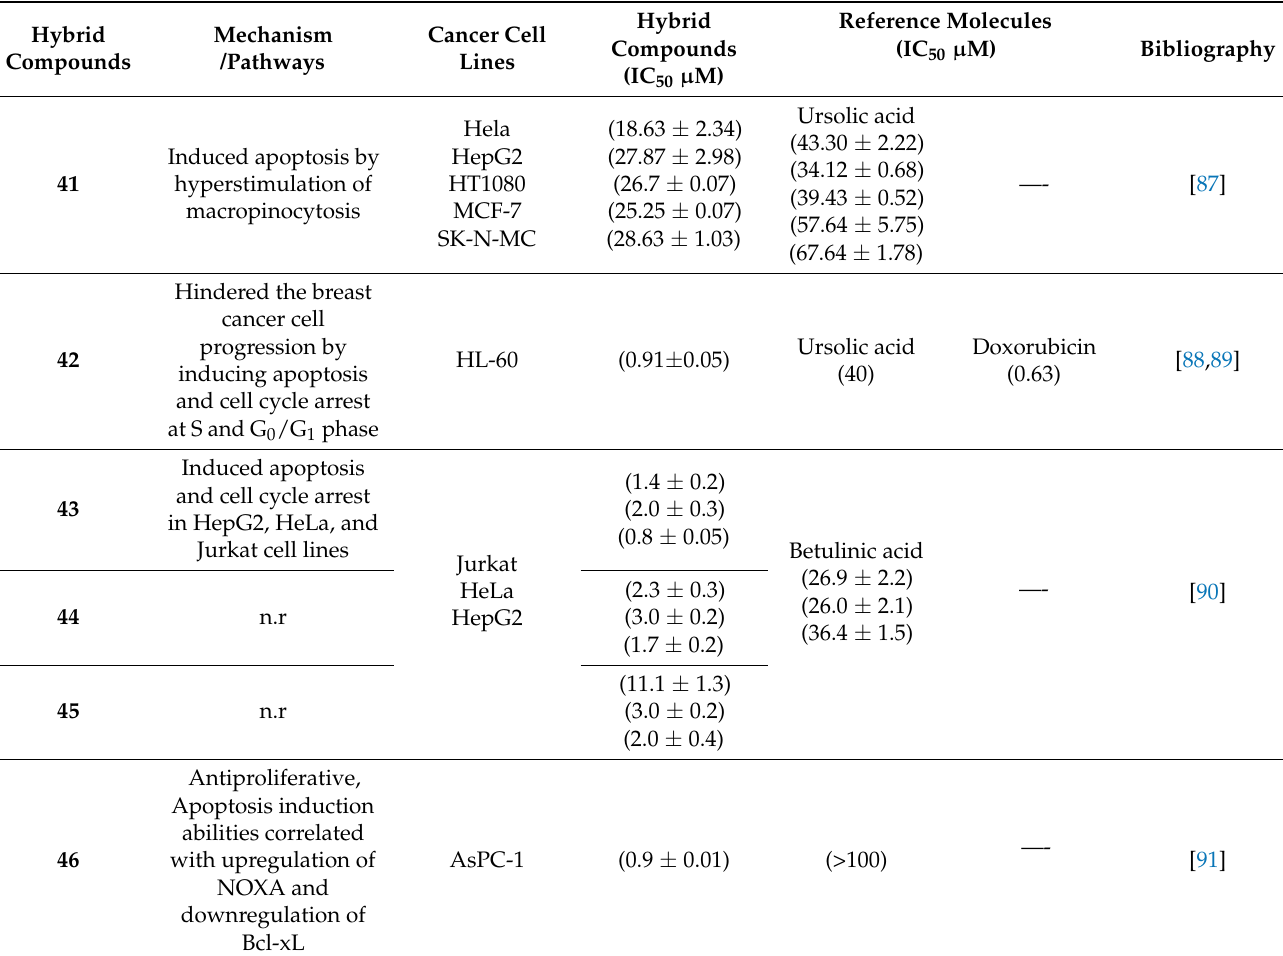
Table 2. Mechanism and cytotoxicity of PTs-based pyrazole scaffolds on different cancer